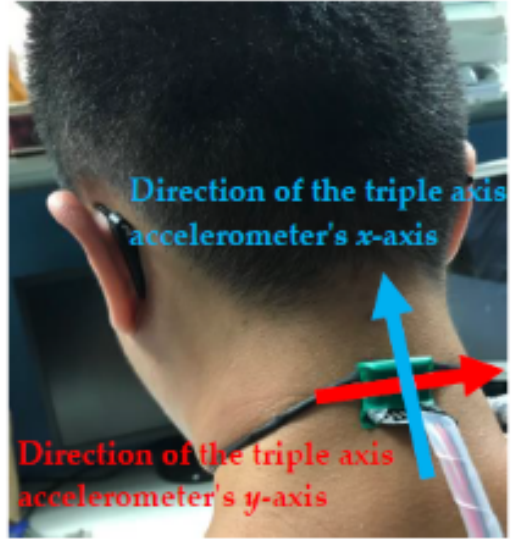
Figure 11. The position and appearance of the smart necklace when worn around the back of the user's neck, with the blue and red arrows indicating the directions of the triple axis accelerometer's x -axis and y -axis,